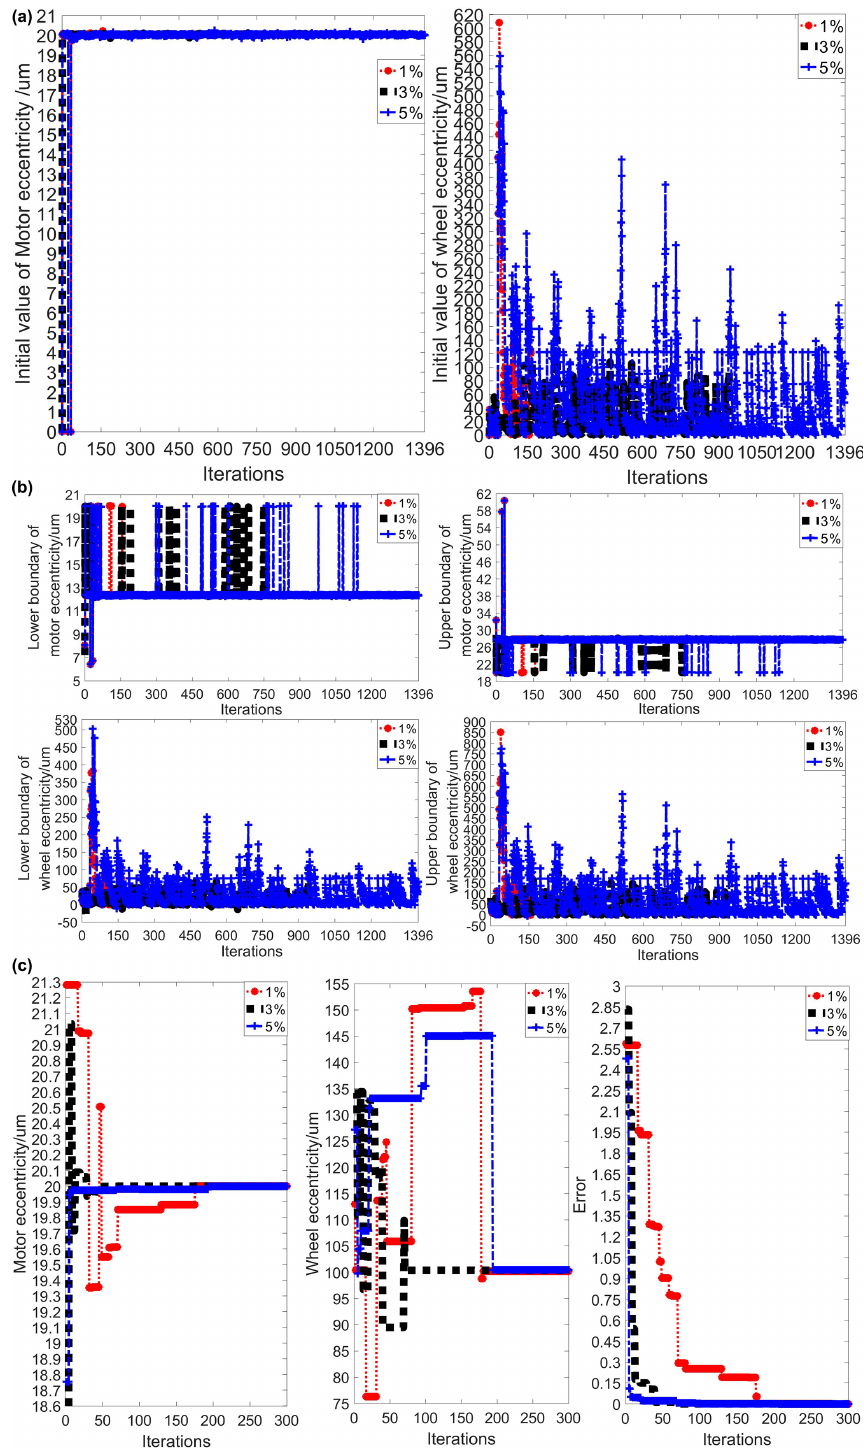
Figure 6. The convergence process of the corresponding solution at each of the iterations. (a) Iterative process of initial eccentricity. (b) It- erative process of interval search. (c) Iterative process of the uGA in the last